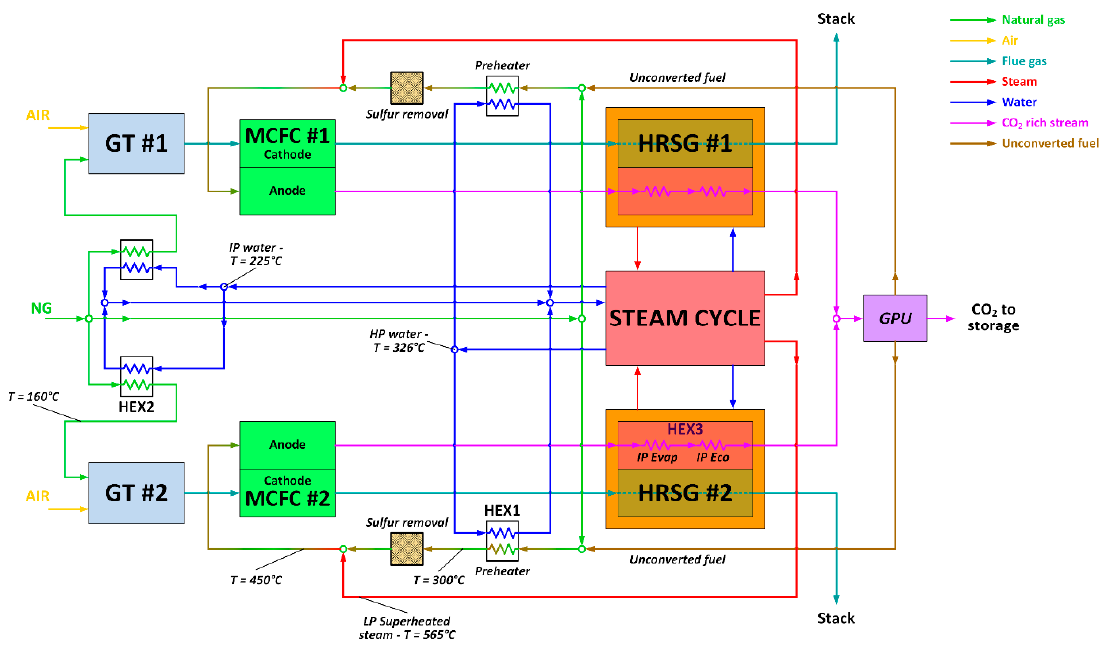
Figure 4. Process flow diagram of the NGCC–MCFC integrated plant.